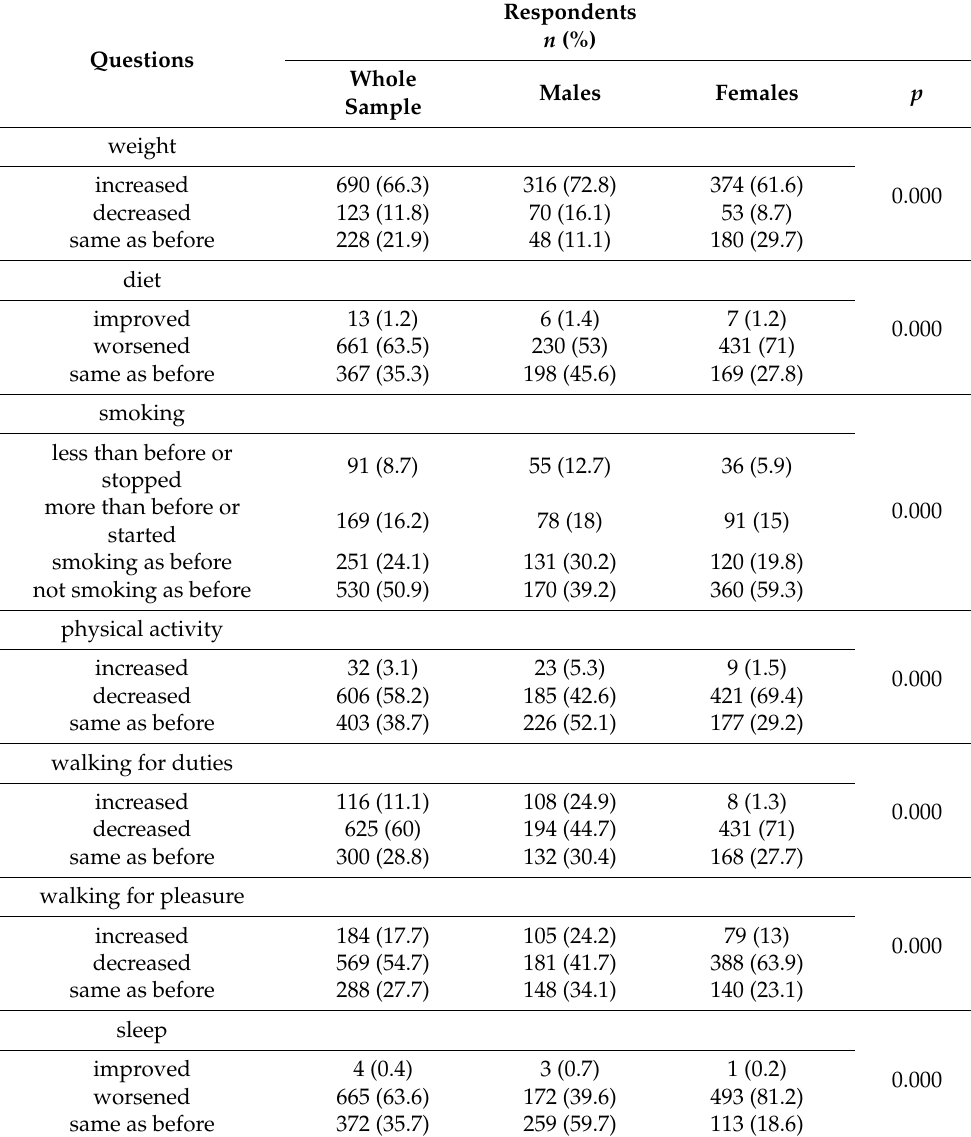
Table 3. Answers related to participants’ lifestyle during the COVID-19